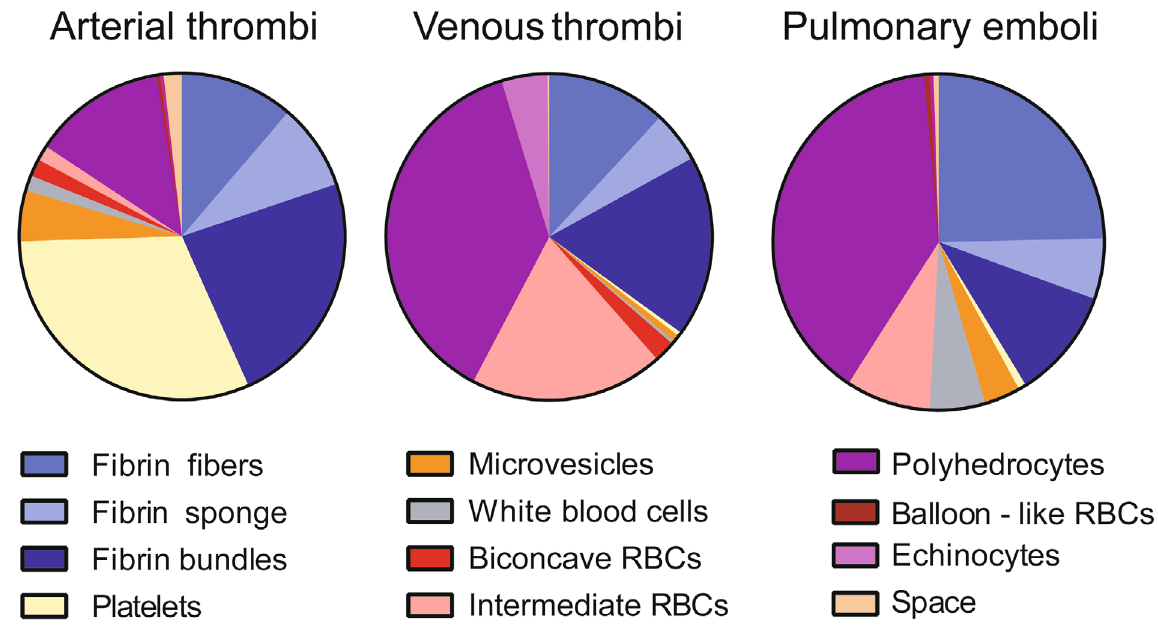
Figure 2. Quantitation of structures identified in pulmonary emboli, arterial and venous thrombi. Thrombi were obtained from patients and prepared for scanning electron microscopy and their composition was quantified as described in the Materials and Methods section. The fibrin component was present as individual fibrin fibers, fibrin sponge and fibrin bundles; erythrocytes as biconcave, intermediate shapes, polyhedrocytes, echinocytes and balloon-like forms. The proportions of total volume occupied by these structures were calculated and presented as pie charts. RBC = red blood